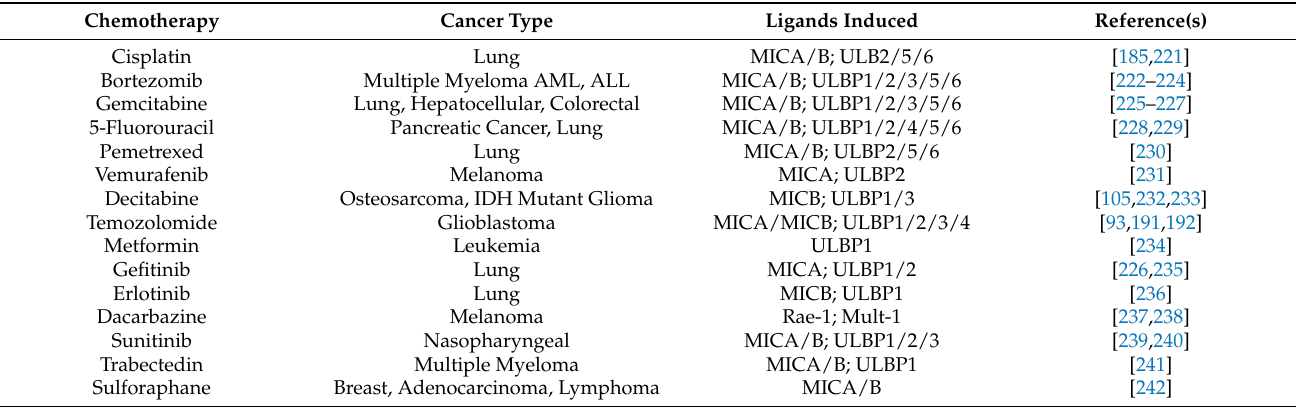
Table 2. Chemotherapies investigated in cancer for NKG2D ligand